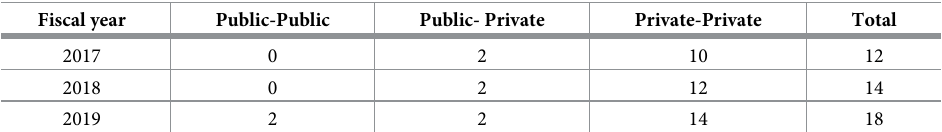
Table 1. The survey year and the type of accredited nursery